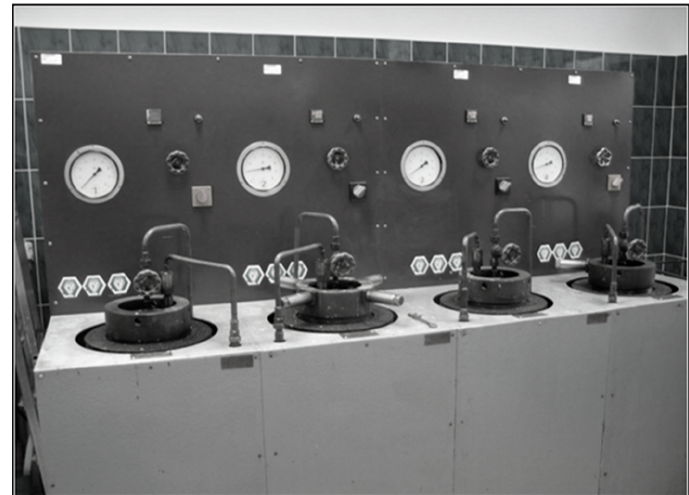
Figure 12. Autoclaves for storing samples of cement slurries.